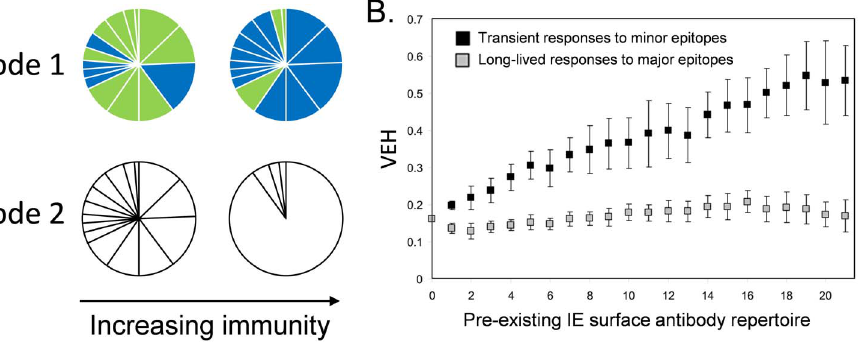
Figure 5. Modeling the relationship between VEH and host IE surface antibodies. In (A) we use pie charts to represent two modes in which acquired immunity may modify the parasite population in a single host. In ‘‘mode 1’’ IE surface antibodies alter the relative abundance of parasites expressing distinct PfEMP1 groups (pie chart slices, colours blue and green). In ‘‘mode 2’’ the acquired IE surface antibody repertoire is able to control a wide range of PfEMP1 variants such that only a small number of variants dominate the PfEMP1 expression profile of the infecting parasite population at any one time. Presented in (B) is an output from the mathematical model by Recker et al. This model was originally used to emphasize how a combination of long-lived antibodies to unique major epitopes and transient antibodies to shared minor epitopes can limit the number of synchronously expressed variants and prolong an infection [19]. Here, we replaced the duration of infection with a measure of the mean VEH of the parasite population following runs of the model with different initial levels of antibodies to major and minor epitopes. The aim was to simulate infections at different stages of their development. The graph shows the relationship between the initial number of each type of antibody [19] and mean VEH. We speculate that the ability of the host to induce transient partially cross-reactive antibodies in the model is equivalent to the observed breadth of IE surface antibody responses described in our dataset. Error bars represent the standard deviations.